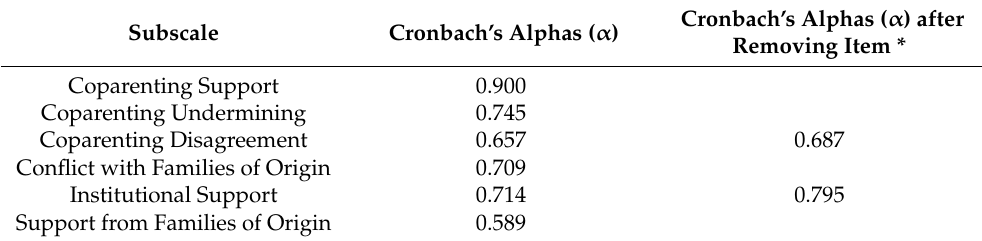
Table 5. Internal Consistency of Coparenting Support; Coparenting Undermining; Conflict with Families of Origin; Institutional Support; and Support from Families of Origin among Sexual Minor- ity